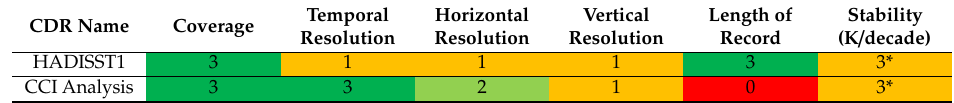
Table 2. Example of Application Performance Matrix (APM) scores for addressing the policymaker question on: Are there trends in North Sea Temperature over the last 15 years that could a ff ect fisheries? Two datasets (HadISST1 and CCl Analyses) provide the CDR requested for this specific application. User requirements (Coverage, Temporal Resolution, etc.) are specified in three levels, 1-target (amber), 2-breakthrough (light green), 3-optimum (dark green), while 0 indicates “Not Acceptable”. Colors and numbers indicate up to which level user requirements are satisfied. (* = treat with